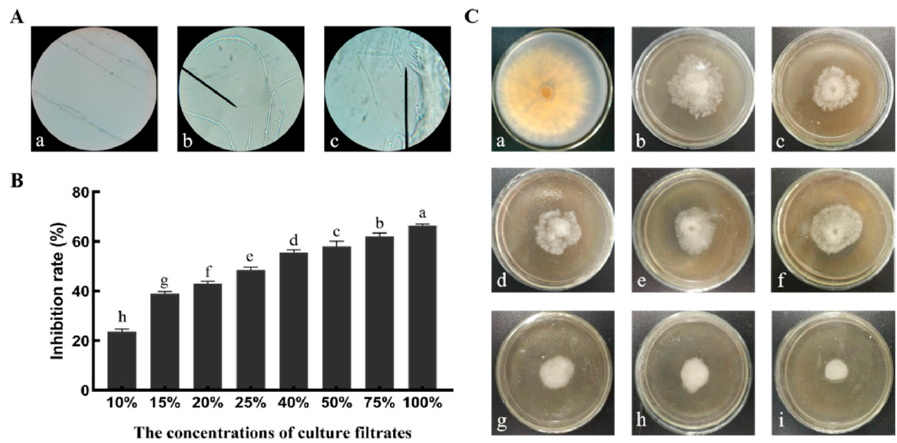
Figure 6. Effect of the B1302 culture filtrate treatment on the growth of R. cerealis mycelia. ( A ), mycelia morphological characteristics of R. cerealis cultivated on PDA medium (( a ), control; ( b ), broken; ( c ), shriveled). ( B ), Inhibition rate of different concentrations of the B1302 culture filtrates on mycelial growth rate; Different lower-case letters on the bars indicate the significant difference at the p < 0.05 level using Duncan’s multiple range test. ( C ), effect of different concentrations of the B1302 culture filtrates on mycelial growth rate in Petri dishes (( a ), 0%; ( b ), 10%; ( c ), 15%; ( d ), 20%; ( e ), 25%; ( f ), 40%; ( g ), 50%; ( h ), 75%; ( i ), 100%) on mycelial growth rate.